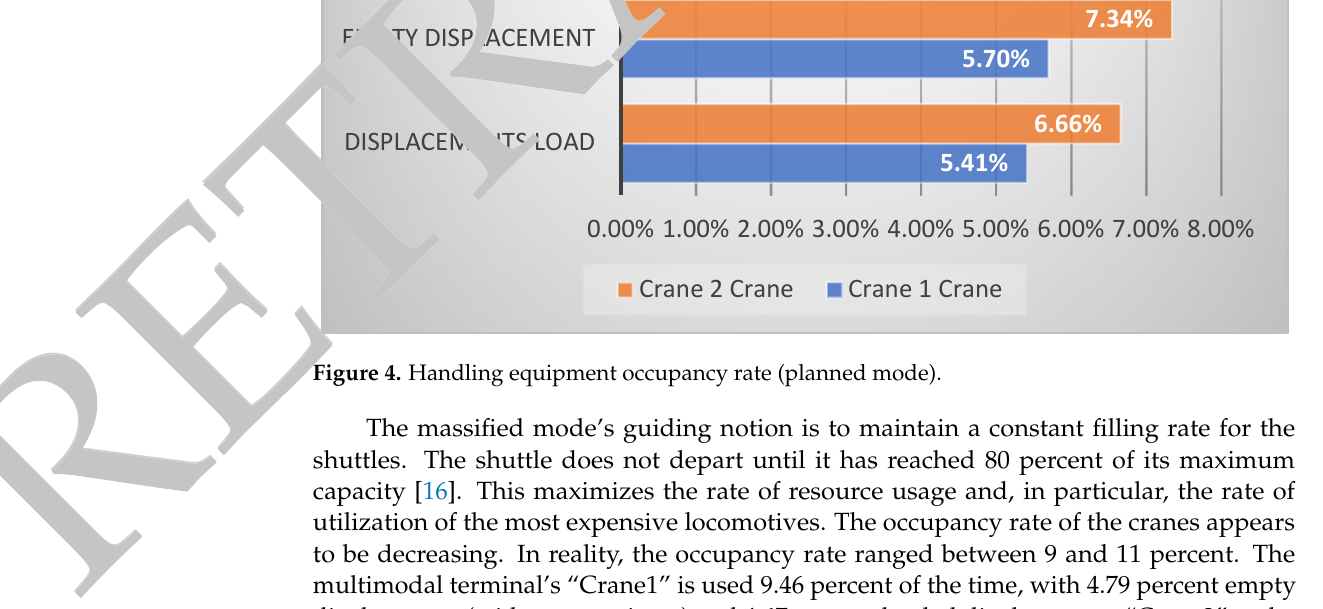
Table 3. Status report for mass mode.